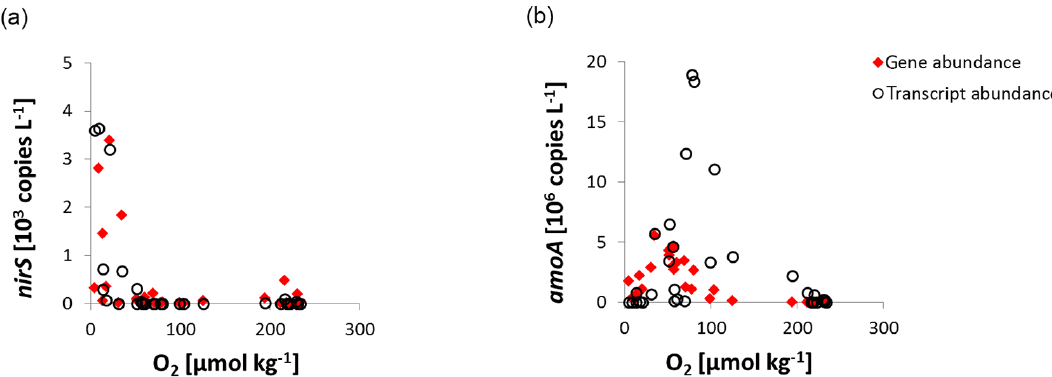
Figure 9. Gene and transcript abundance vs. O 2 concentrations of samples from the eddy observations (eddy_1 and eddy_2) and CVOO. (a) shows the key gene for denitrification, nirS , coding for the nitrite reductase, (b) shows archaeal amoA as key functional gene of ammonia oxidation, coding for the ammonia monooxygenase. Gene abundances are denoted in red, transcript abundances are indicated by black